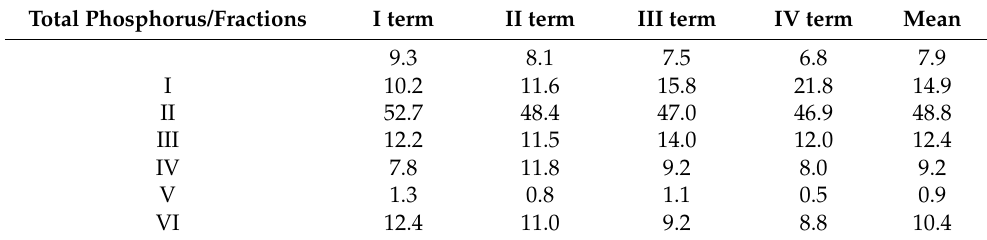
Table 4. Phosphorus content in g/kg DM and the fraction share (%) in the digestate. Total